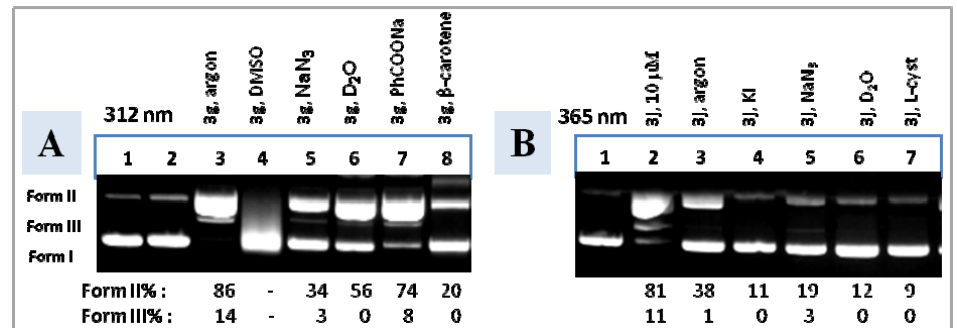
Figure 4. Gel electrophoresis data. ( A ): Mechanistic studies involved at the DNA photo-cleavage by derivative 3g (500 µ M) with UV light (312 nm). Lane 1: DNA without UV irradiation; Lane 2: DNA with UV irradiation; Lane 3: DNA + 3g + argon; Lane 4: DNA + 3g + DMSO 20%; Lane 5: DNA + 3g + NaN 3 20 mM; Lane 6: DNA + 3g + D 2 O; Lane 7: DNA + 3g + PhCOONa 2 mM; Lane 8: DNA + 3g + β -carotene 200 µ M. ( B ): Mechanistic studies involved at the DNA photo-cleavage by derivative 3j (10 µ M) with UV light (365 nm). Lane 1: DNA with UV irradiation; Lane 2: DNA + 3j ; Lane 3: DNA + 3j + argon; Lane 4: DNA + 3j + KI 250 µ M; Lane 5: DNA + 3j + NaN 3 20 mM; Lane 6: DNA + 3j